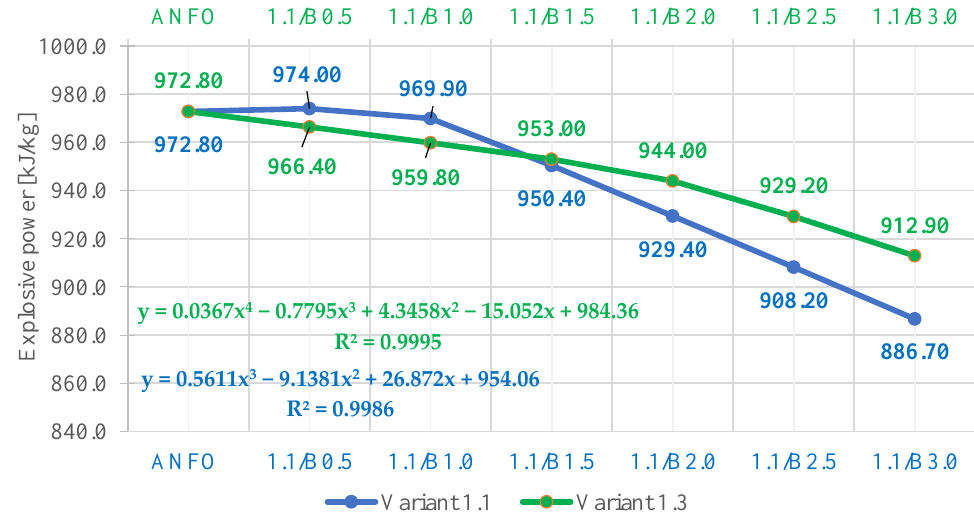
y = equation of the trendline function R 2 — the coefficient of the quality of the model fit Figure 3. Changes in the explosive power for individual explosives. Figure 3. Changes in the explosive power for individual explosives.